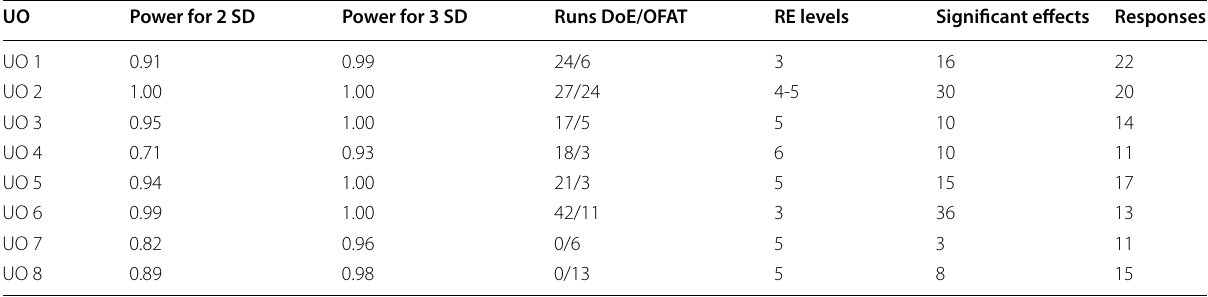
Table 1 Average statistical power over all effects to detect an effect within 2 or 3 standard deviations from the set point. Note that those values represent the worst case that assumes a full model, i.e., a model that includes all quadratic and interaction effects UO Power for 2 SD Power for 3 SD Runs